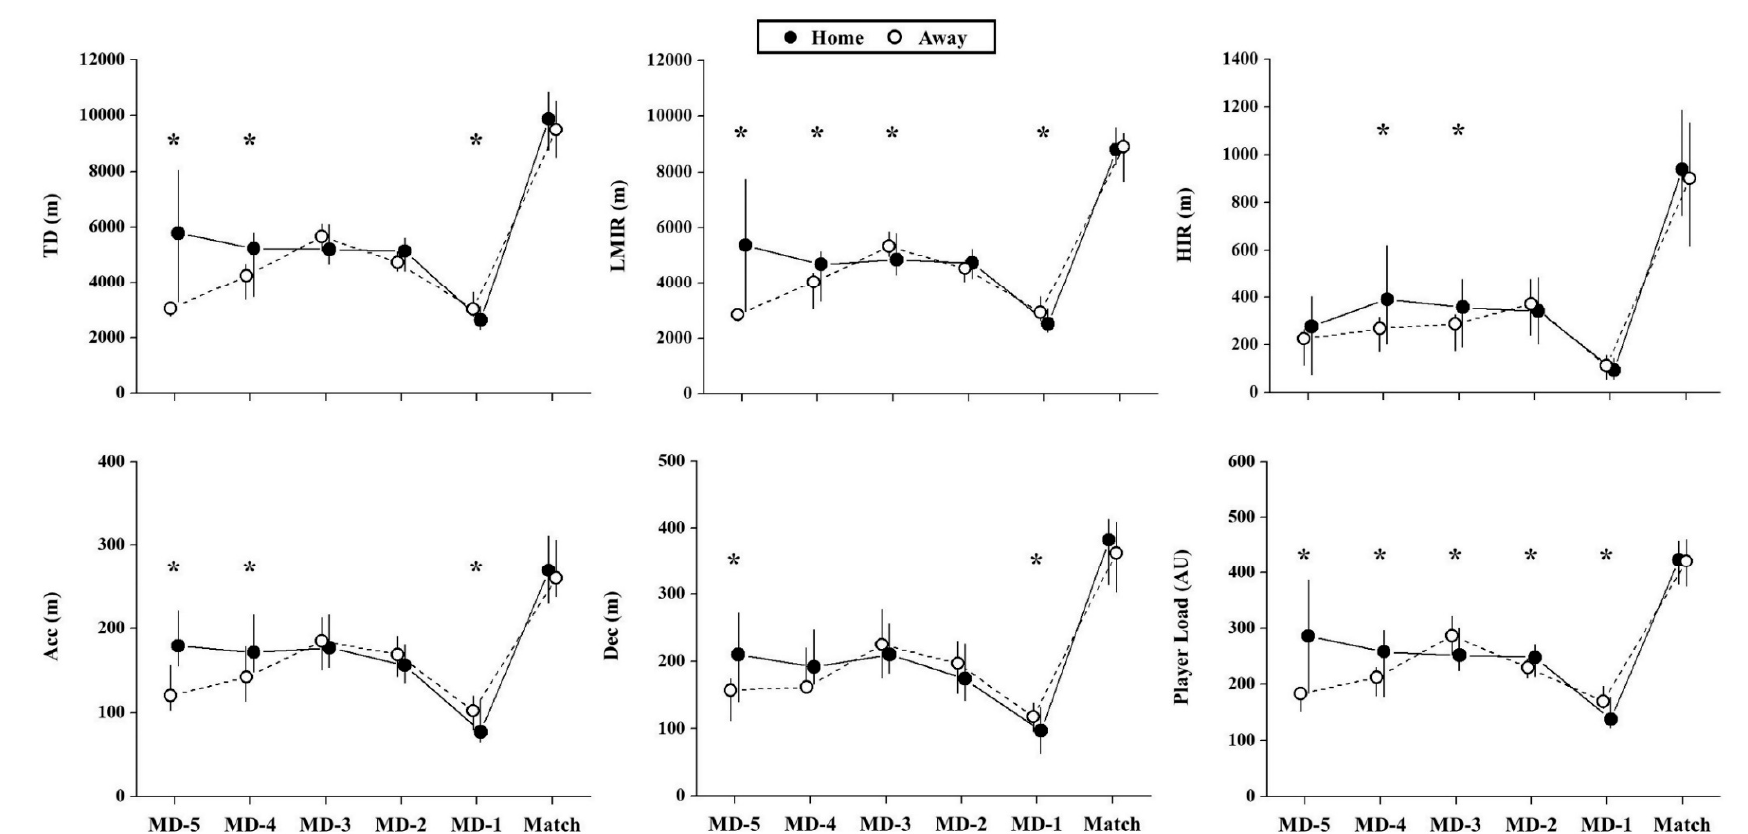
Figure 1. Effects of match location on weekly external load parameters. TD: total distance covered; LMIR: total distance covered under low to moderate-intensity running ( ≤ 18 m·h − 1 , m); HIR: total distance covered under high-intensity running (>18 km·h − 1 ); Acc: total distance covered under high-intensity acceleration ( ≥ 2 m·s − 2 ); Dec: total distance covered under high-intensity deceleration ( ≤− 2 m·s − 2 ); MD-5 = five days before the match; MD-4 = four days before the match; MD-3 = three days before the match; MD-2 = two days before the match; MD-1 = one day before the match. *: Significant di ff erences between days before playing home vs. away ( p < 0.05).